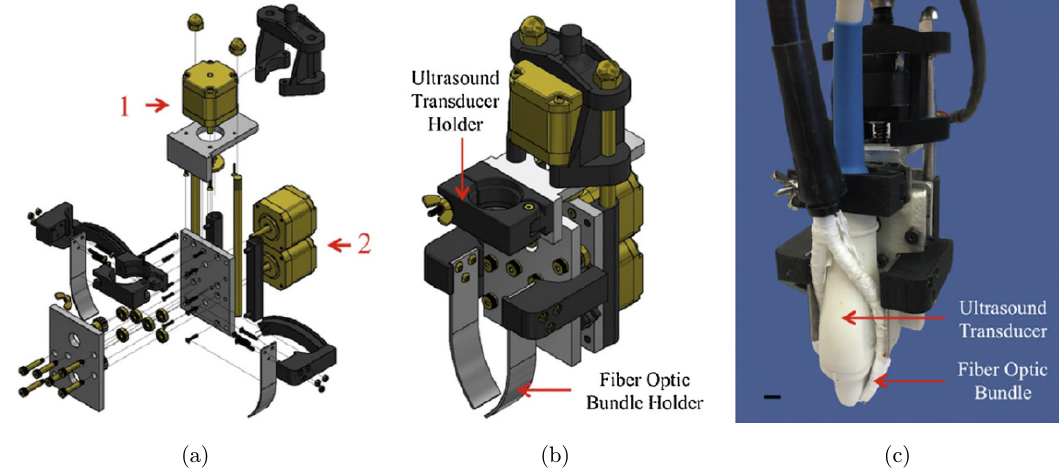
Fig. 5. The adjustable probe proposed in Ref. 42. Exploded (a), presentation (b), and constructed (c) images of the probe. Reprinted from Photoacoustics, 12, G. S. Sangha, N. J. Hale, C. J. Goergen, Adjustable photoacoustic tomography probe improves light delivery and image quality, 6 – 13., Copyright (2018), with permission from